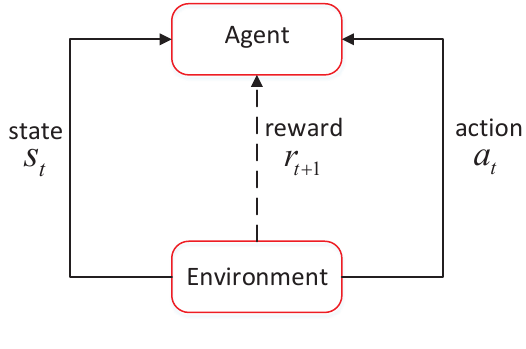
Figure 4. Agent–environment